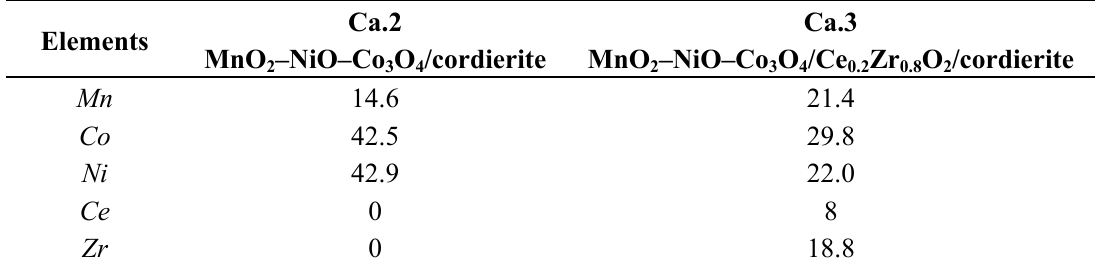
–NiO–Co O /cordierite) 2 3 4